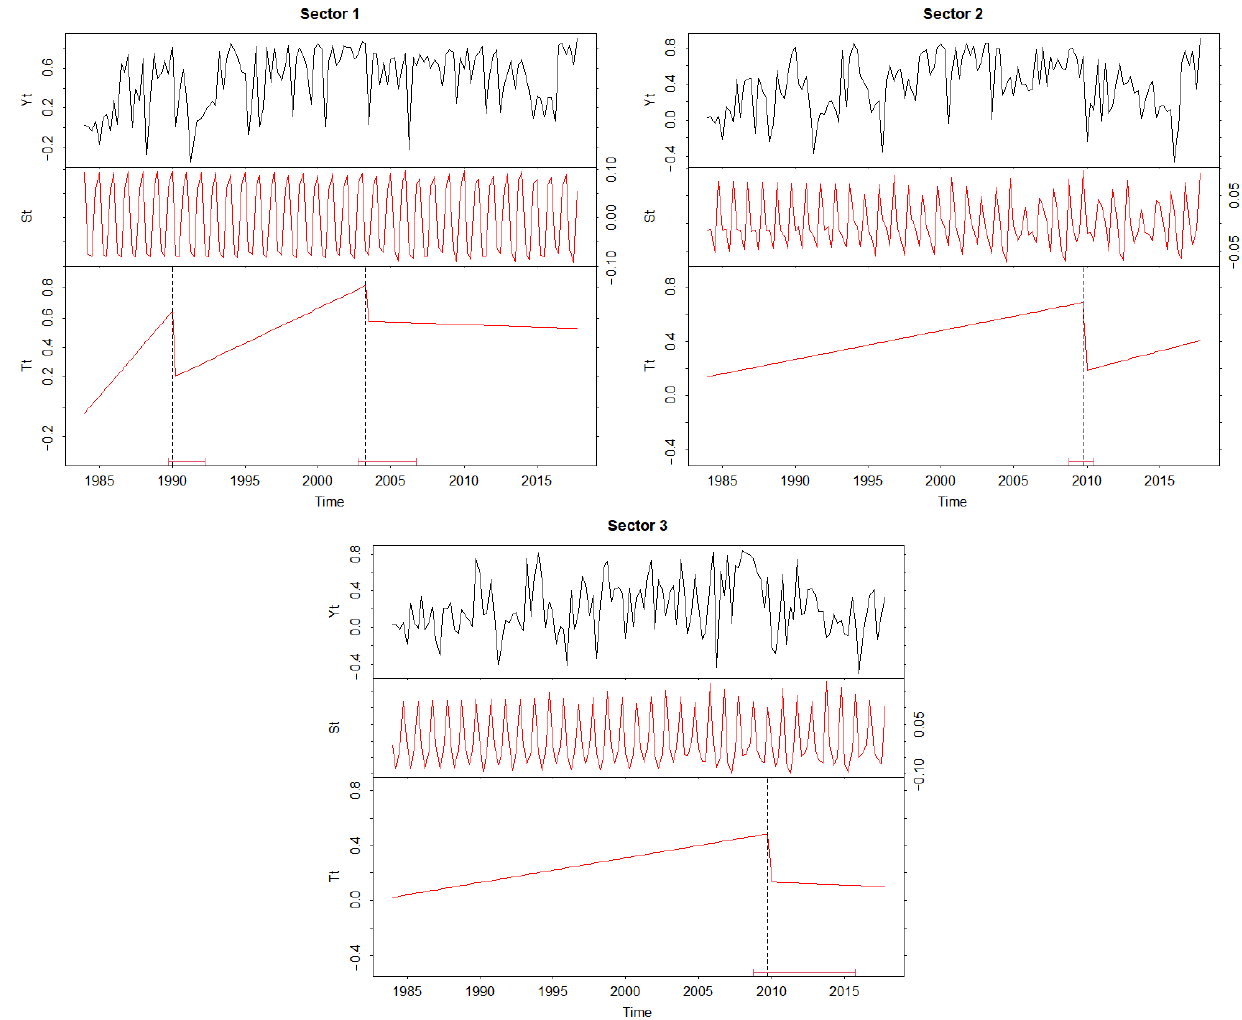
Figure 7. The NDVI time series (Y t ) and its seasonality (S t ) and trend (T t ) components of the segmented areas in the near dam compartment (Sectors 1, 2, and 3 from Figure 3c). The correlations between the original time series of the mean NDVI and each climate variable remained low for the three compartments, as well as the trend components, which did not reach 0.3, regardless of the compartment or climate variable considered. However, the cross correlations between the components of seasonality showed that the persistence of macrophyte banks close to the dam had a cyclical behavior positively correlated with fluctuations in air temperature (0.7695) and precipitable water (0.724). This did not occur near the river, which had a negative correlation of less than 0.5 with meridional wind. In the middle of the reservoir, the highest correlation of the seasonal behavior of the mean NDVI was observed in the variable precipitable water ( − 0.7694).